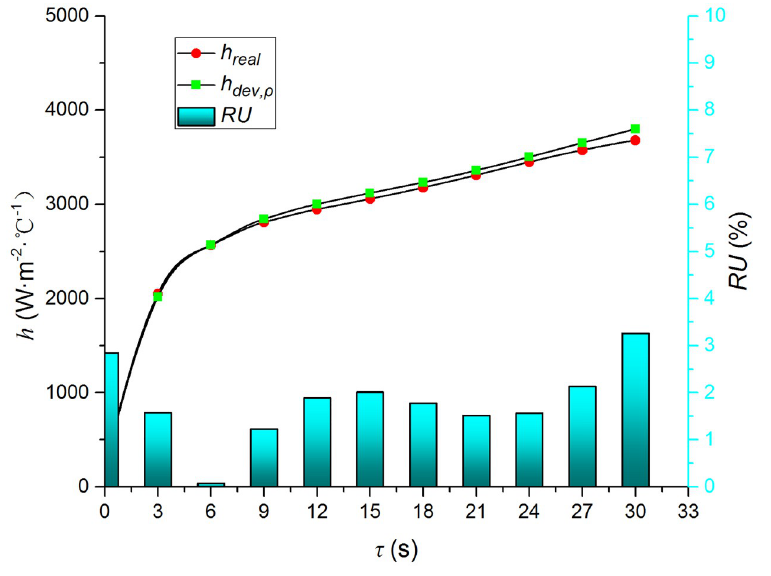
Fig 11. Comparison of h dev , ρ and h